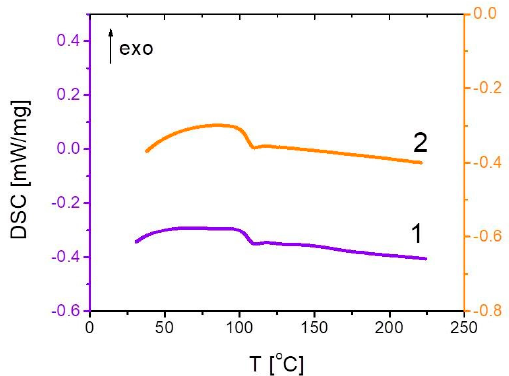
Figure 1. Differential scanning calorimetry (DSC) curve of pure polystyrene (PS) pellets (1st and 2nd scan).